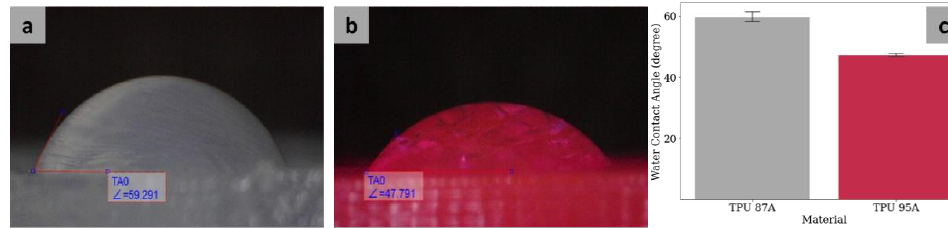
Figure 7. Representative photographs of TPU 87A ( a ) and TPU 95A ( b ). Water contact angle measurement results for the two materials ( c ).